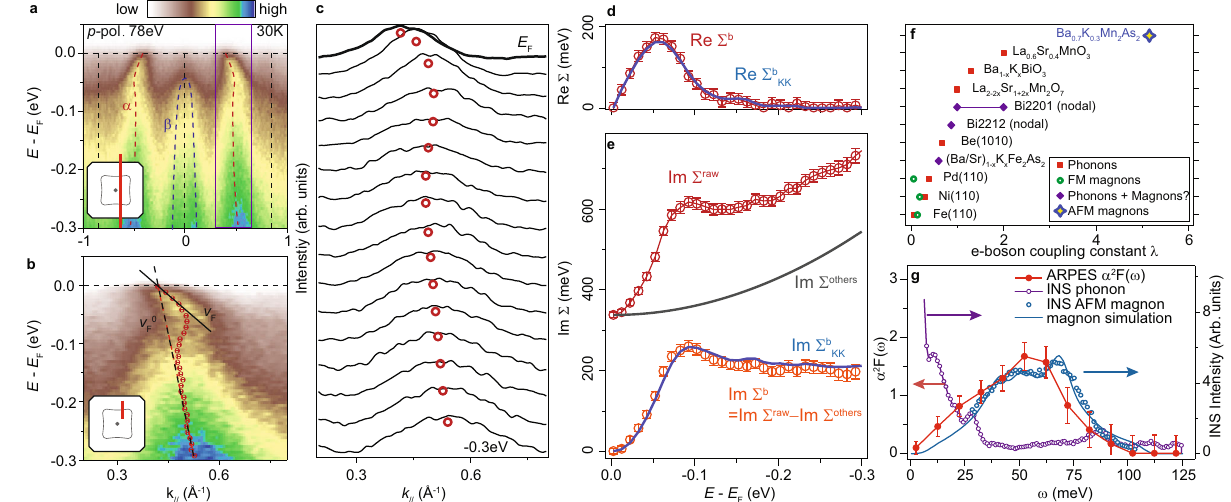
Fig. 2 | Kink and electron – magnon interactions in Ba 0.7 K 0.3 Mn 2 As 2 . a Photoemissionspectraslightlyoffthezonecenter,wherethe β 0 bandisoutsideof theenergywindow. b Zoom-inofthepurplerectangularregioninpanel a ,overlaid with the MDC peak positions (red circles), fi tting of the Fermi velocity v F (black solid line) and the velocity of large-scale dispersion v 0 F (black dashed line), and the parabolic estimation of the "bare band" dispersion (red dashed curve). A momentum-independent background is subtracted. c MDCs of spectra in panel b , where the red circles indicate the peak positions from fi ttings. d Re Σ b (red circles)and theKKtransformationofIm Σ b inpanel e (Re Σ b KK ,bluecurve). e Im Σ raw from the FWHM of MDCs peaks (red circles), KK transformation of Re Σ b (Im Σ b KK , bluecurve),andthebackground(Im Σ others ,graycurve).TheIm Σ b (orangecircles)is